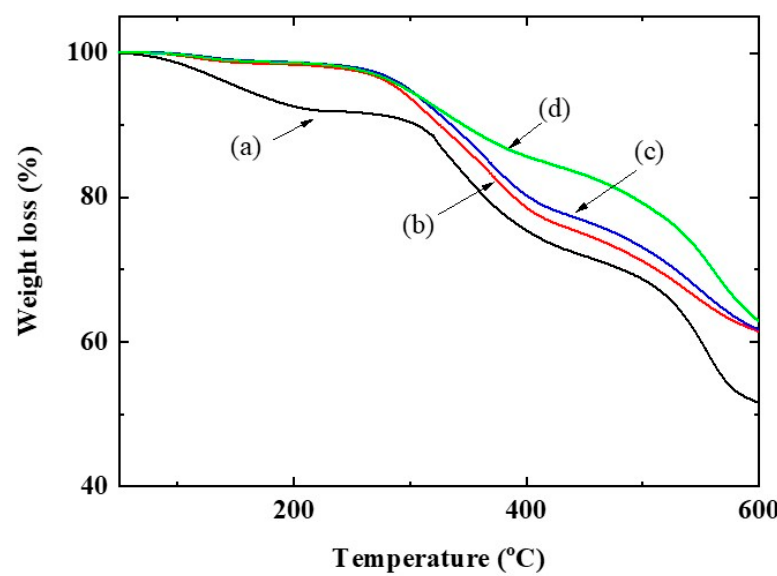
Figure 2. Thermal stabilities in a helium gas flow at a heating rate of 20 °C/min of (a) synthesized sulfonated polyphenylsulfone (SPPSU), (b) CSPPSU after the heat treatment at 180 °C, and CSPPSU membranes activated (c) without and (d) with NaOH solution process.